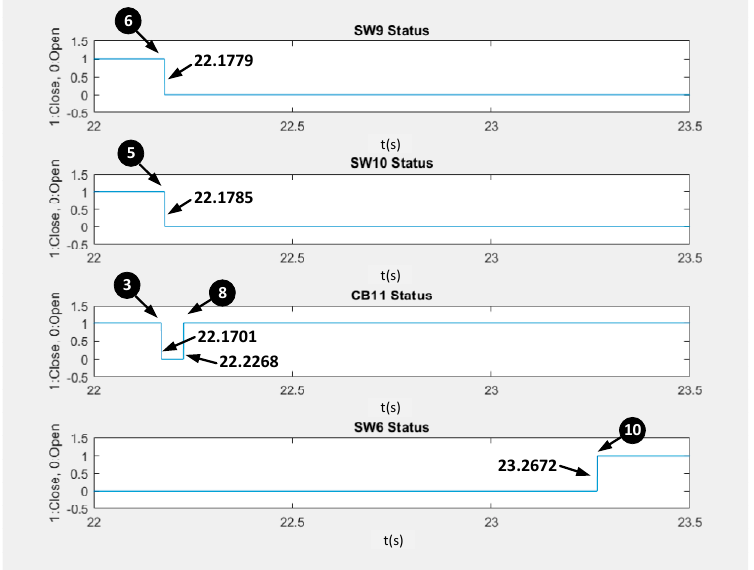
Figure 9. F-FDIR process time using GOOSE communication (including load transfer time be- tween nested microgrids).